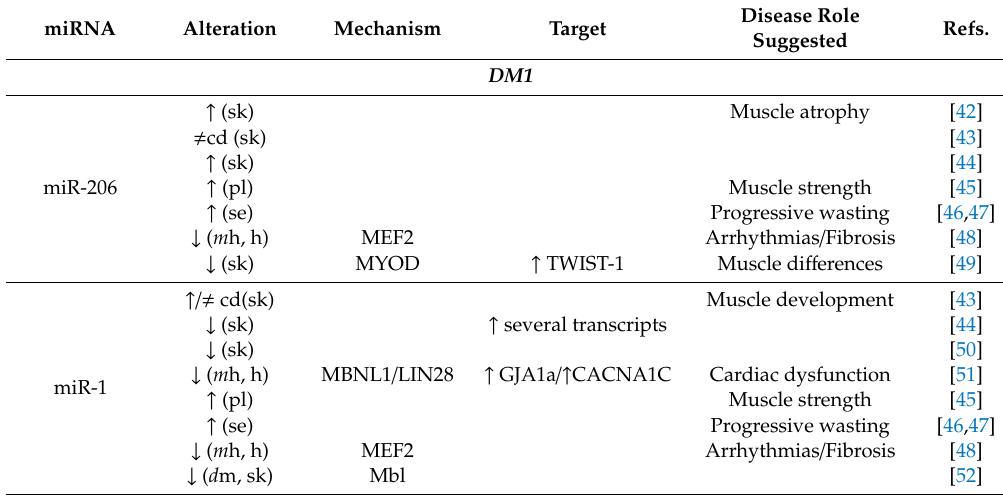
Table 1. Altered miRNAs in DM1 or